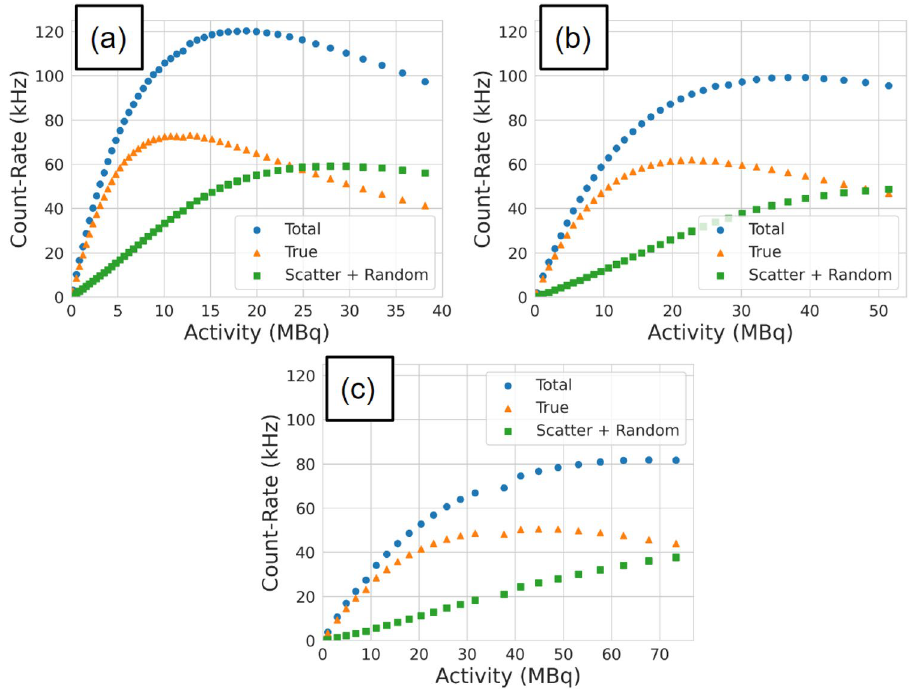
Figure 3. The total, true, and scatter + random coincidence count rates as a function of source activity for ( a ) 250 mm, ( b ) 525 mm, and ( c ) 800 mm head